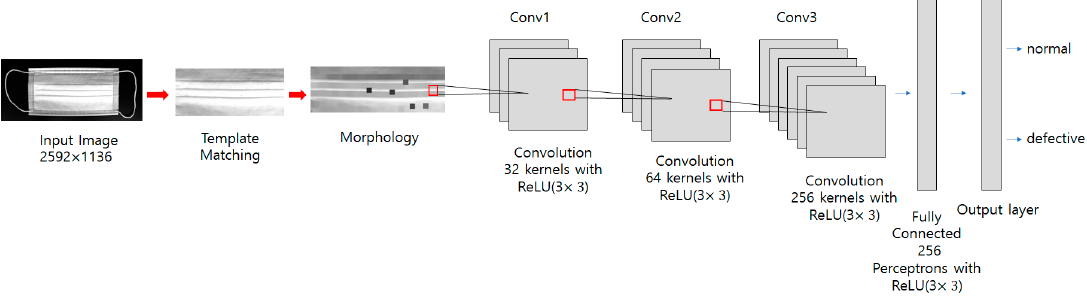
Figure 11. Dotted defect CNN model used in the proposed method.